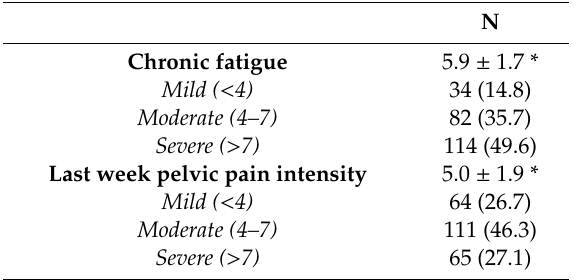
Table 2. Intensity of chronic fatigue and pelvic pain in women with